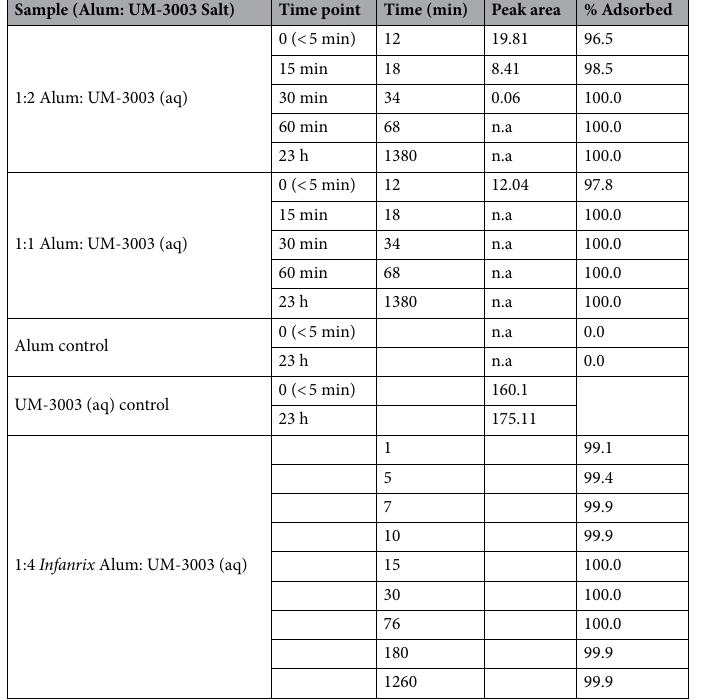
Table 1. Phospholipidation enables adsorption of UM-3003 to alum and Infanrix vaccine. Adsorption kinetics of UM-3003 [molecular weight (MW) of 1047.42)] onto 2% alhydrogel alum and DTaP alum respectively. Aluminum hydroxide derived from DTaP ( Infanrix ) vaccine, which has preexisting pertussis antigen adsorbed to its surface, was evaluated up to 23 h. UM-3003 fully adsorbed (~ 96–100%) to the alum/antigen within 30 min, with or without excess